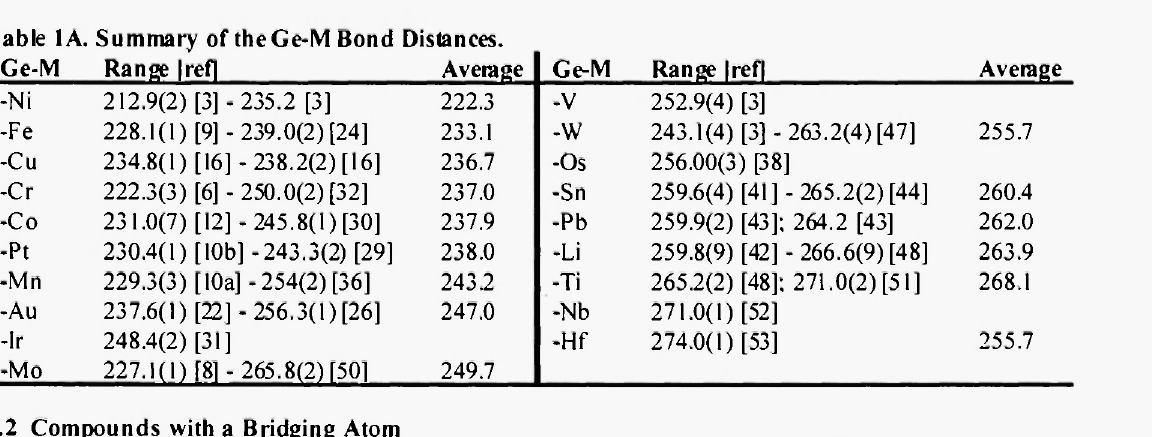
Table 1 A. Summary of theGe-M Bond